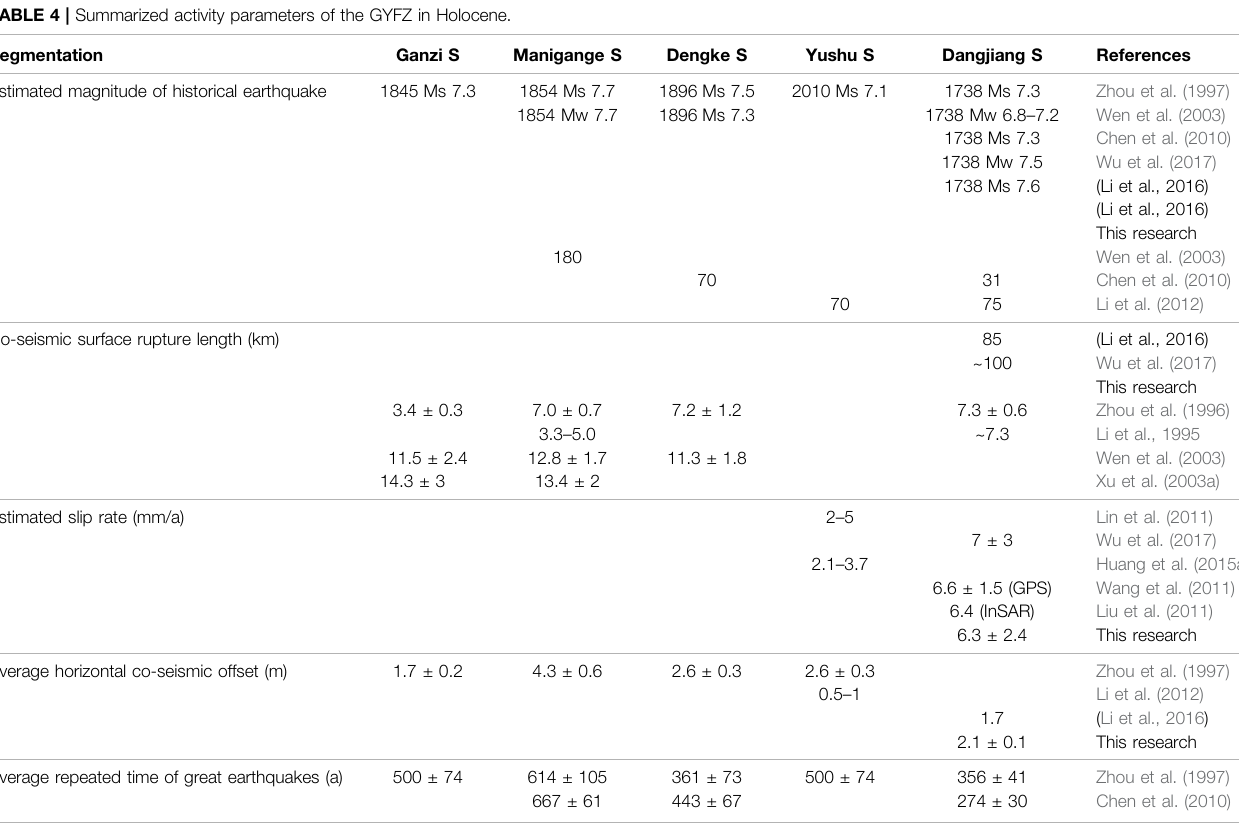
TABLE 4 | Summarized activity parameters of the GYFZ in